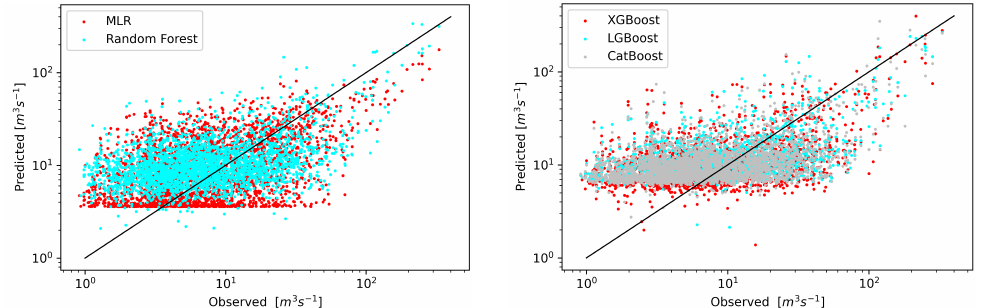
Figure 5. Forecast with default parameters based only on precipitation data.